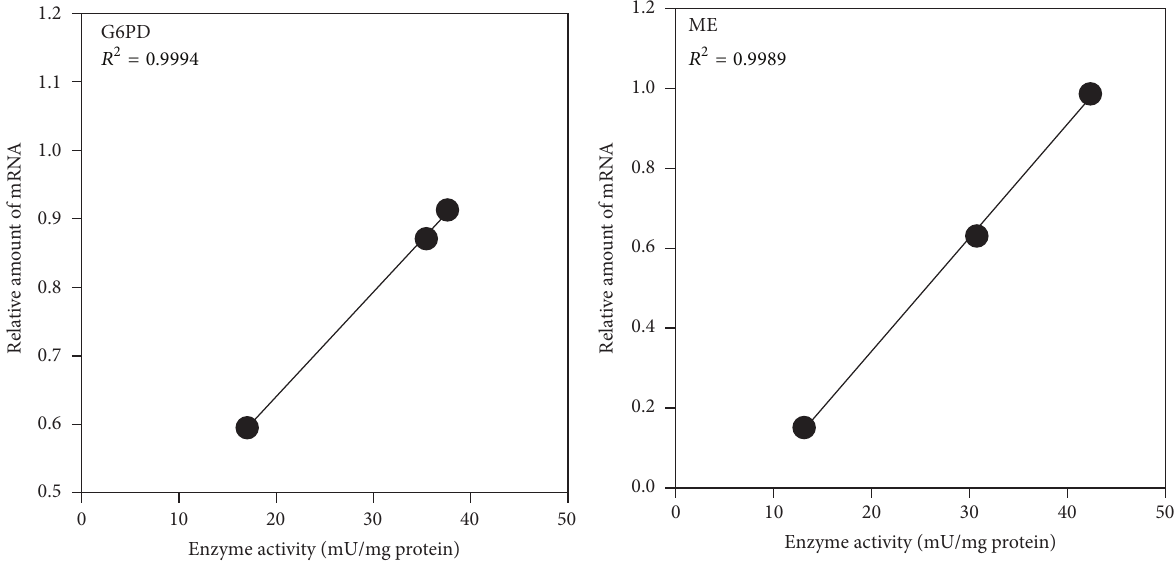
Figure 2: Correlations of liver G6PD and ME activities with their mRNA levels in 10% SPI, 10% SPI + cystine, and 10% SPI + methionine groups. mRNA levels were shown as relative amount to 𝛽 -actin